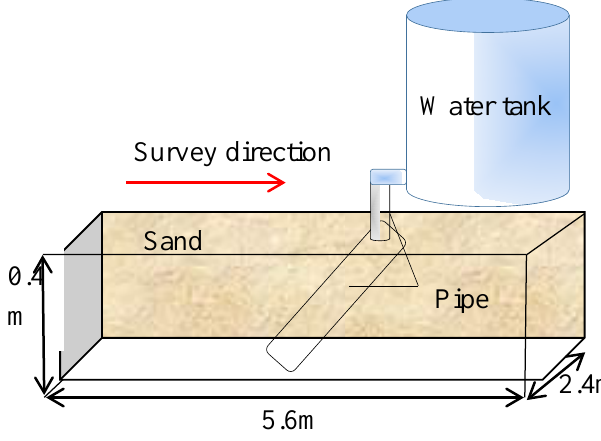
Figure 5 . Schematic diagram of the test bed